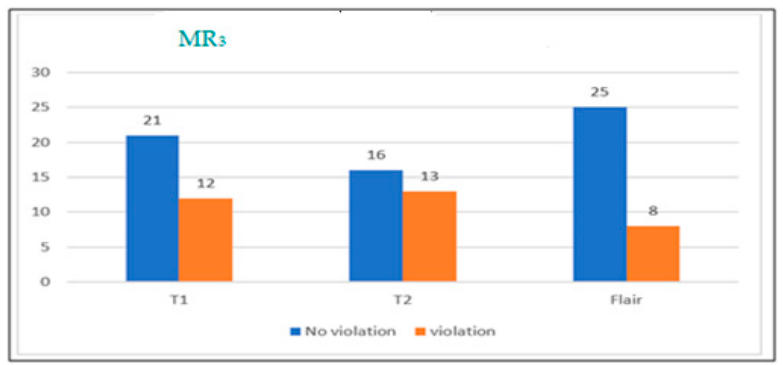
Figure 9. No. of test cases violating MR 3 for T1, T2, and flair image.